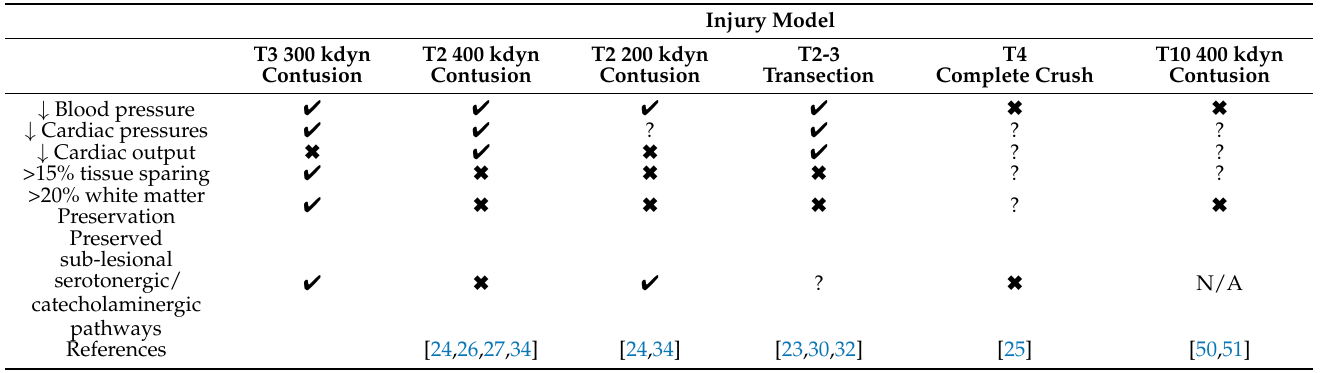
Table 2. Comparisons with previous models of SCI that have been used to induce cardiovascular dysfunction. Injury